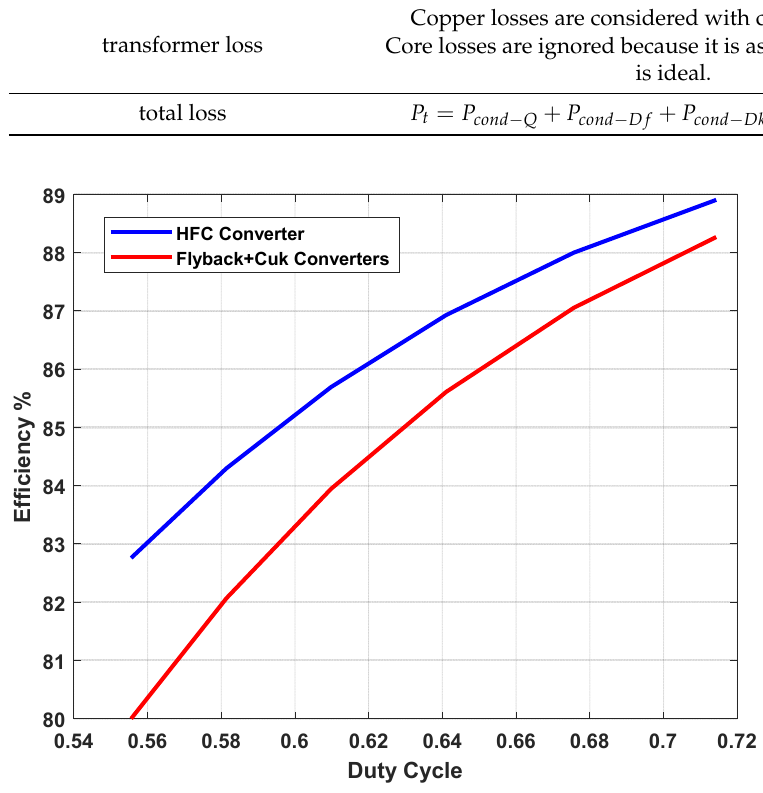
Figure 10. The efficiency comparison over duty cycle variation.